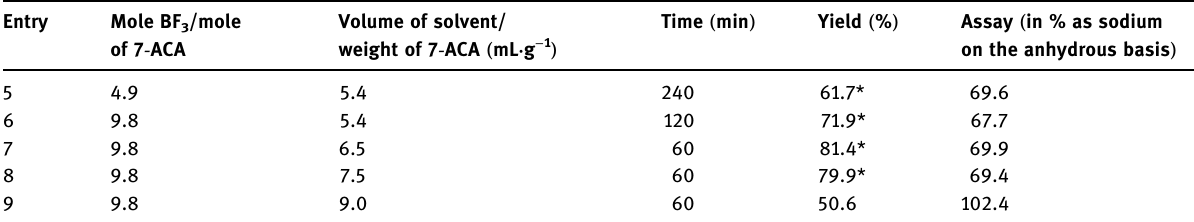
*Without the fi ltration of boric acid and its salt after reaction quenching.